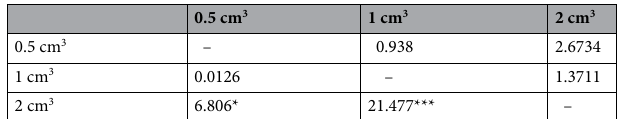
Table 3. Results of ANCOVA showing the F -value and probability levels (Bonferroni corrected) of interaction between weight loss and hyphal coverage (log-transformed) for the three wood block sizes. The three values at the bottom left side of the table show the F -values of the relationship between absolute weight loss and hyphal coverage. The three values at the upper right side of the table show the F -values of the relationship between percentage weight loss (log-transformed) and hyphal coverage (log-transformed). * P < 0.05; *** P <